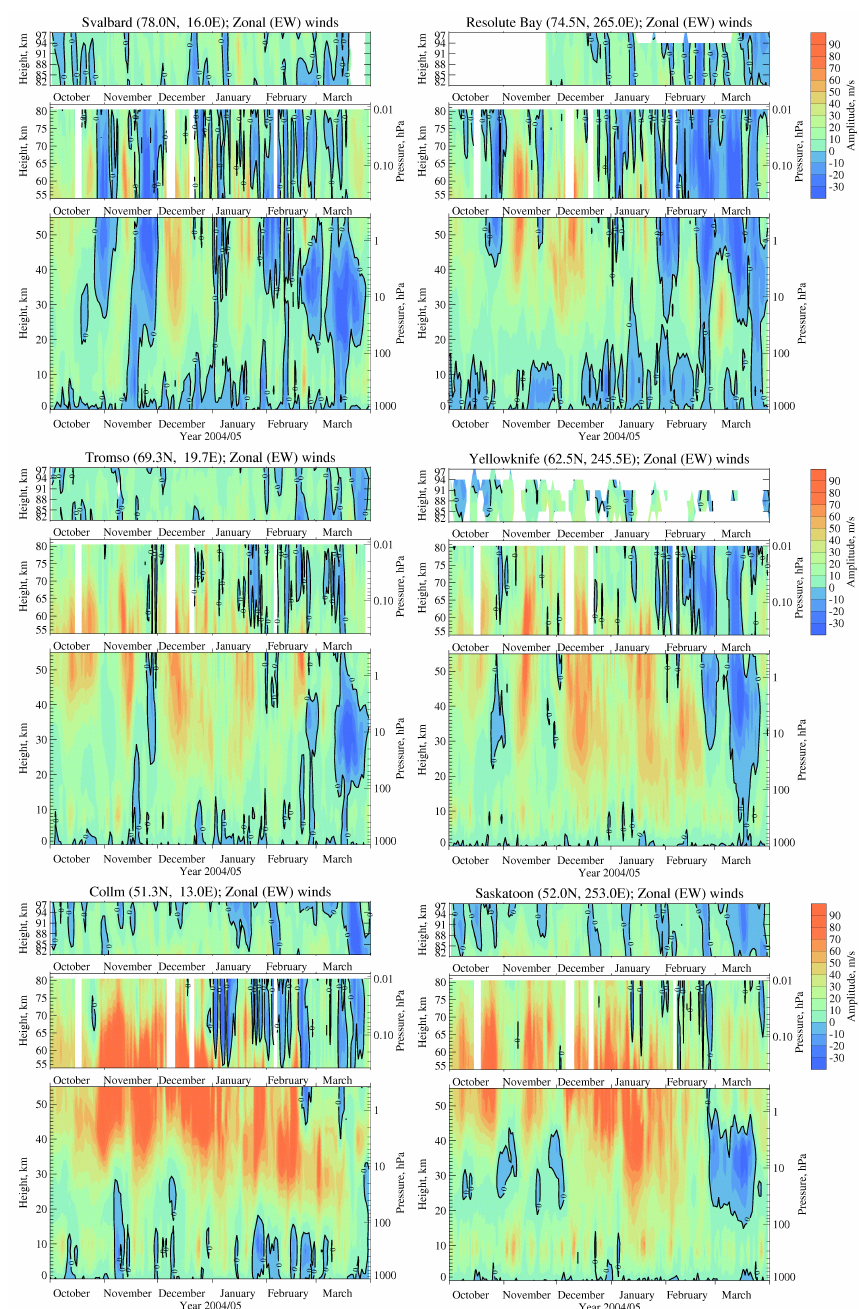
Fig. 6. Evolution of zonal winds in the height range from the surface up to the upper mesosphere (97km) in the time interval from October 2004 until March 2005 for the Svalbard, Resolute Bay, Tromsø, Yellowknife, Collm, and Saskatoon locations. The plot for each station consists of 3 parts: the MetO daily winds are shown in the bottom panel (0–55km); the middle panel (55–82km) is filled with daily winds obtained from the thermal wind equation using temperature gradients calculated from Aura MLS data; and mean winds obtained from the (mean + diurnal tide + semidiurnal tide) fit to the radar hourly measurements are used in the top panel (82–97km). The fit uses a 3-day window shifted by 1